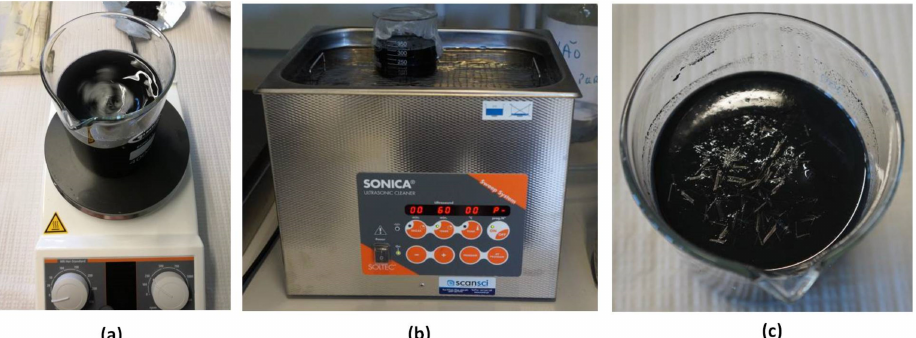
Figure 3. Preparation of aqueous suspensions: ( a ) magnetic stirring, ( b ) ultrasonication and ( c ) the aqueous suspension containing CFs and